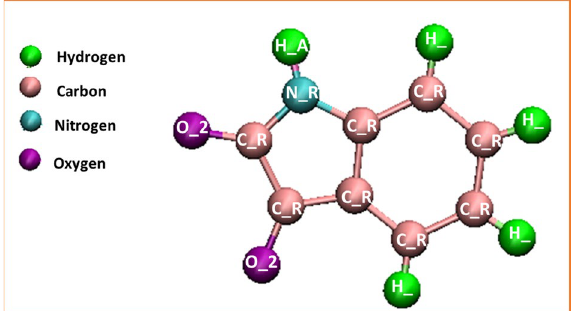
Figure 1. The molecular structure of anticancer drug Isatin and its atoms as represented using the DREIDING force